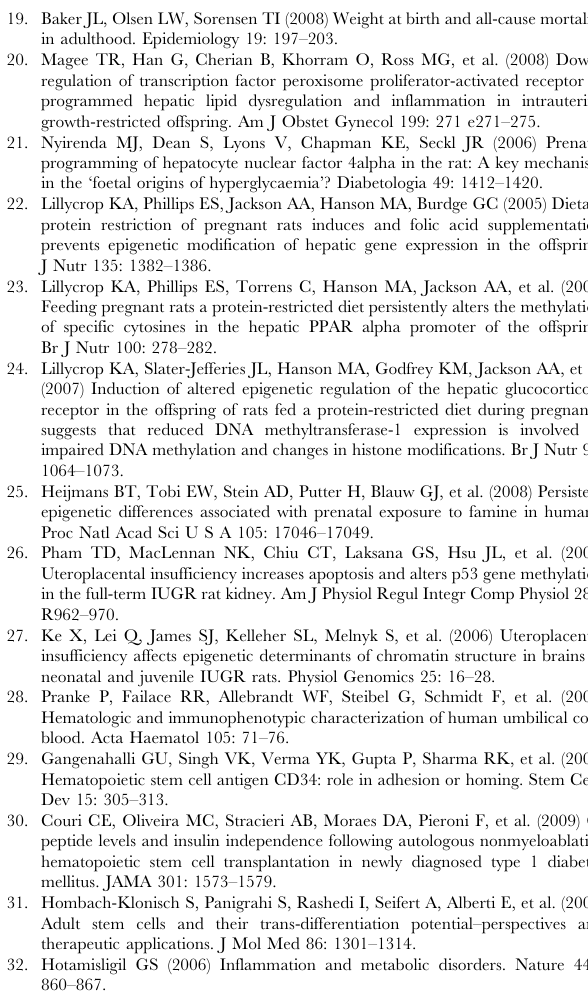
man genome, March 2006, UCSC Genome Browser). HELP data as log2(HpaII/MspI) ratios are shown along the x-axis, with methylation towards the left and hypomethylation towards the right. MassArray data for the same loci are plotted along the y-axis, from 0% (hypomethylated) to 100% (methylated). Table S1 Neonatal and Maternal Characteristics for IUGR and Controls